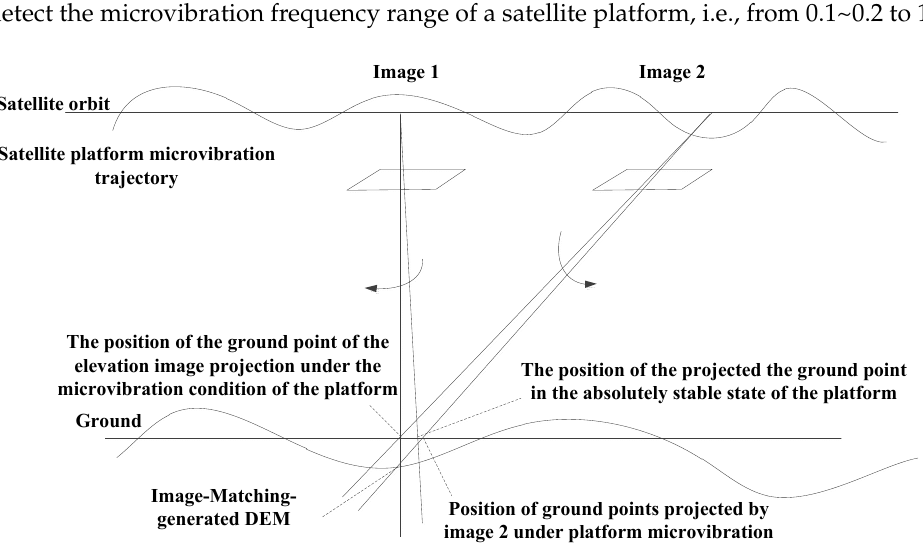
Figure 5. Diagram of microvibration detection based on surveying and mapping products [14]